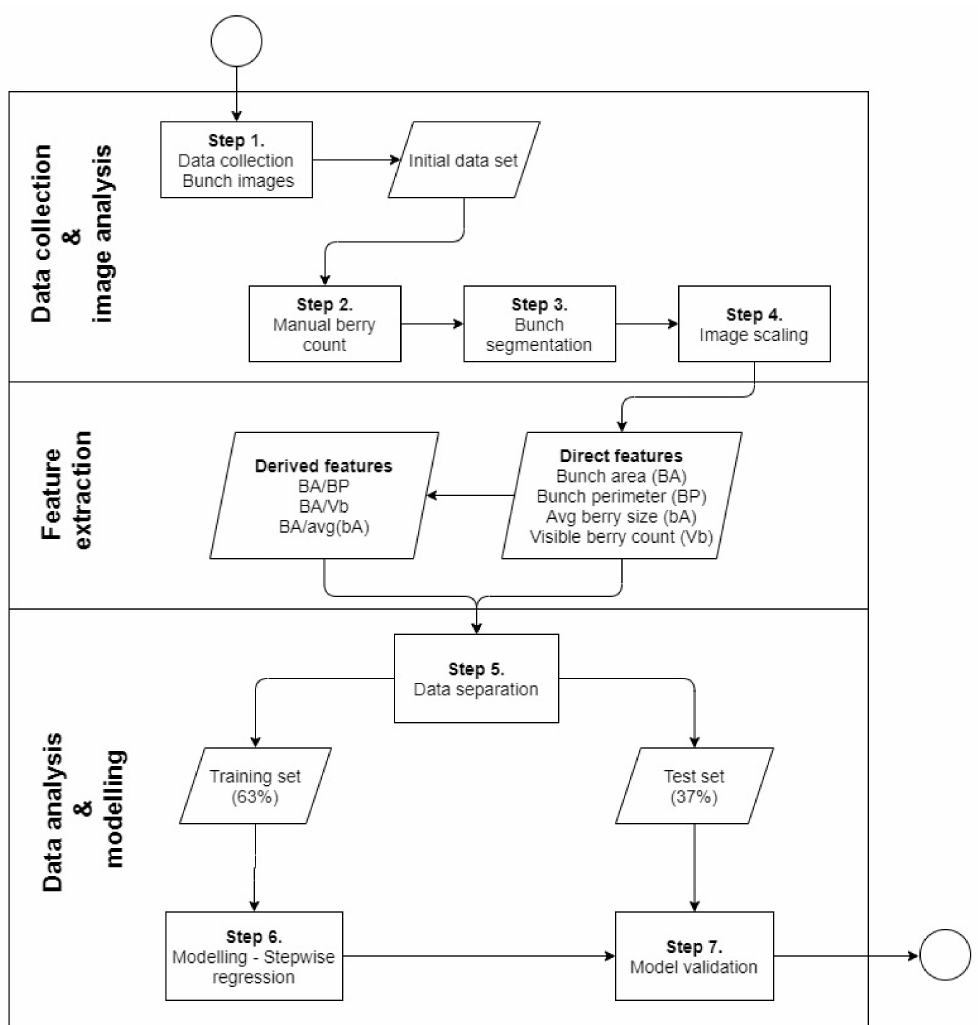
Figure 2. Flowchart describing the work’s methodology from data collection to